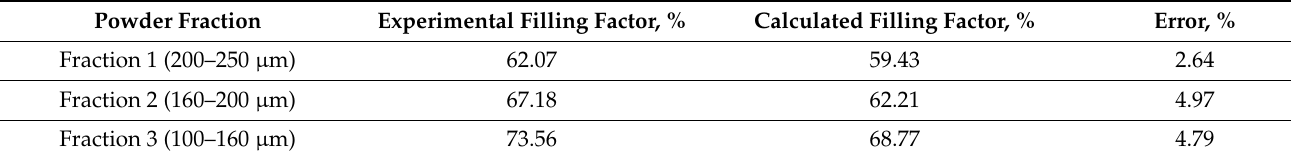
Table 2. Filling factors for polyhedral